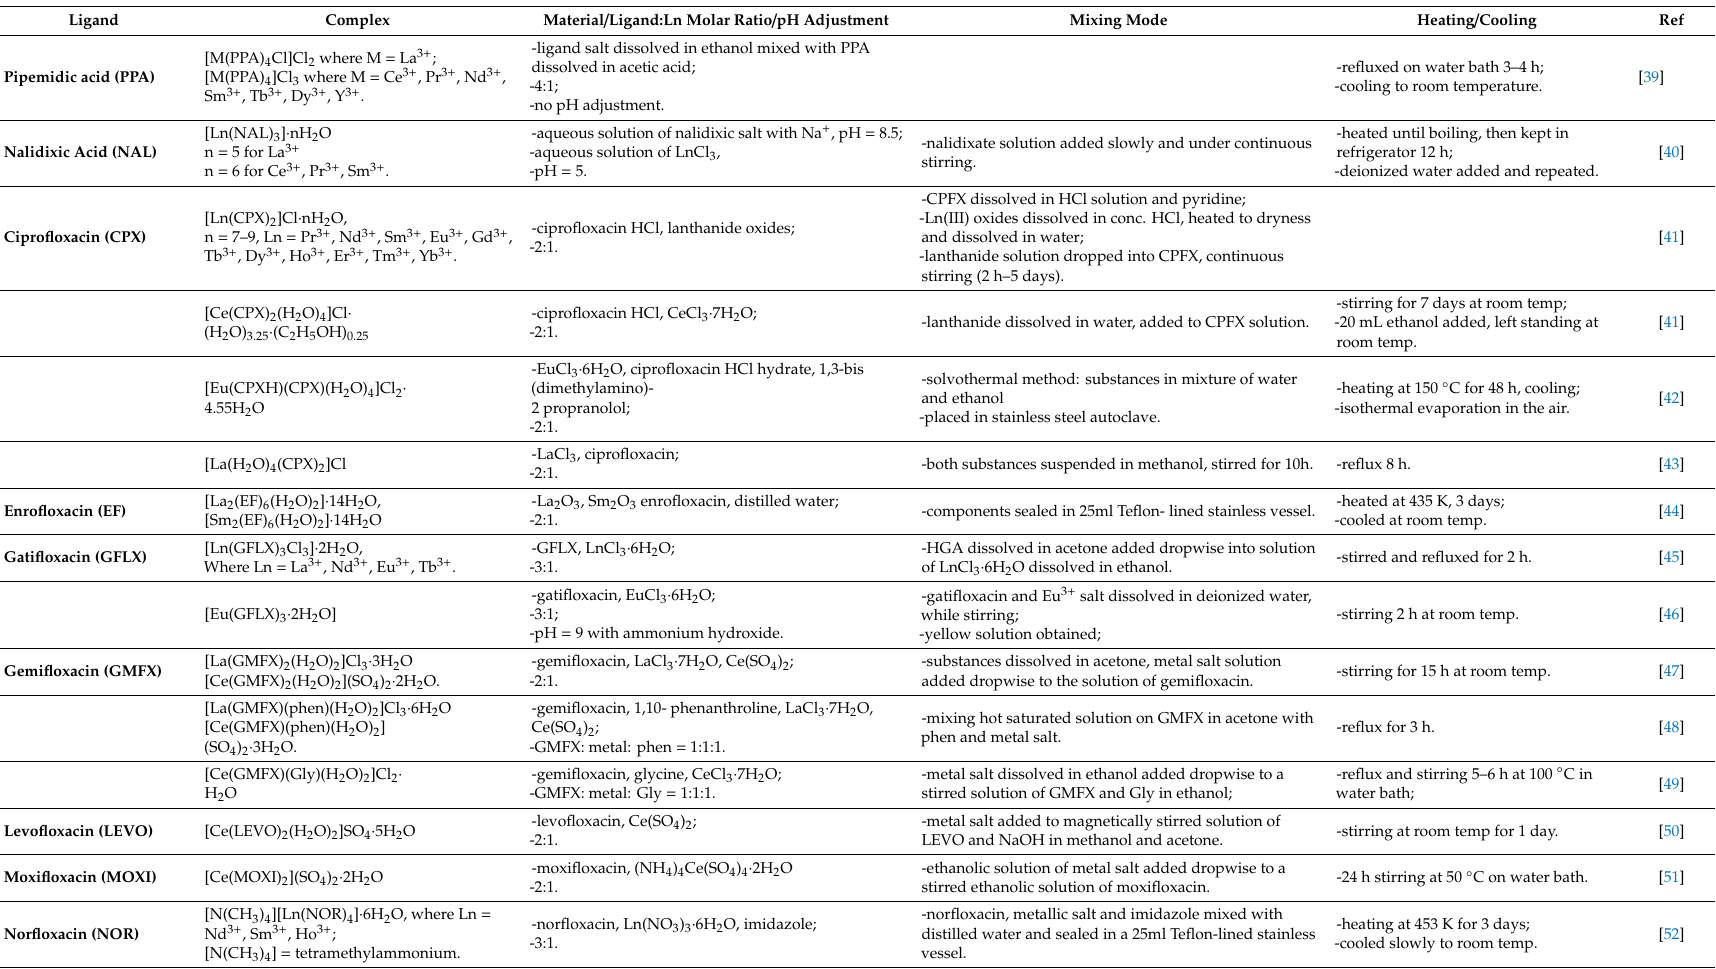
Table 1. Methods for the synthesis of quinolone complexes with lanthanide